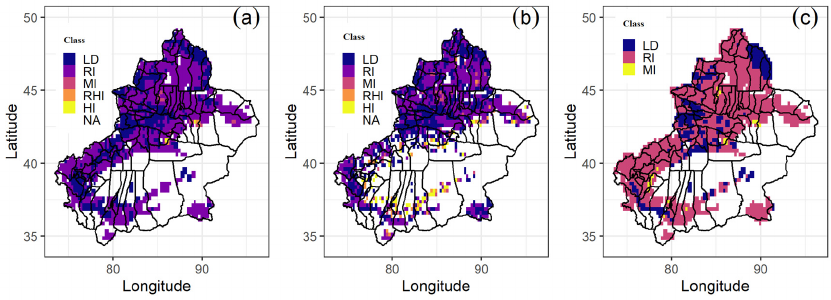
Figure 7. Latitude change trend of WUEs; ( a ) eWUE; ( b ) tWUE; ( c ) pWUE. Table 2. Trend change and mean annual of WUEs percentage (units: %). Trend of WUEs